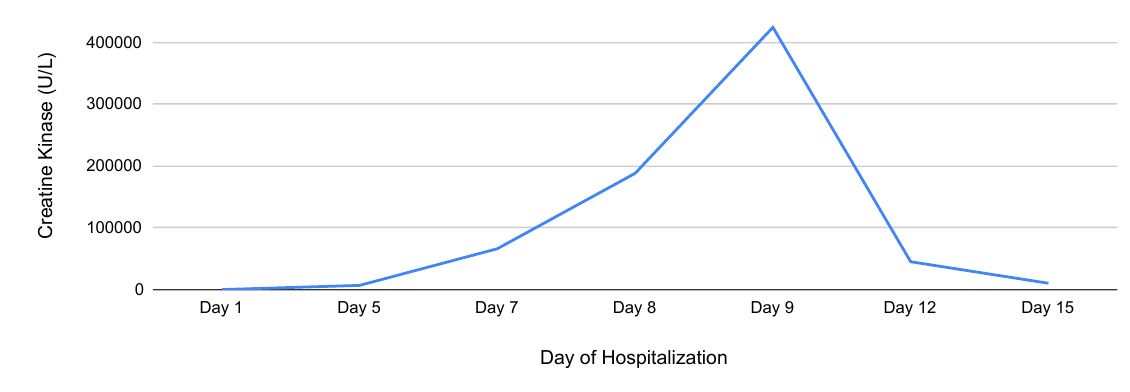
Fig. 3. Creatine kinase (CK) levels during hospital